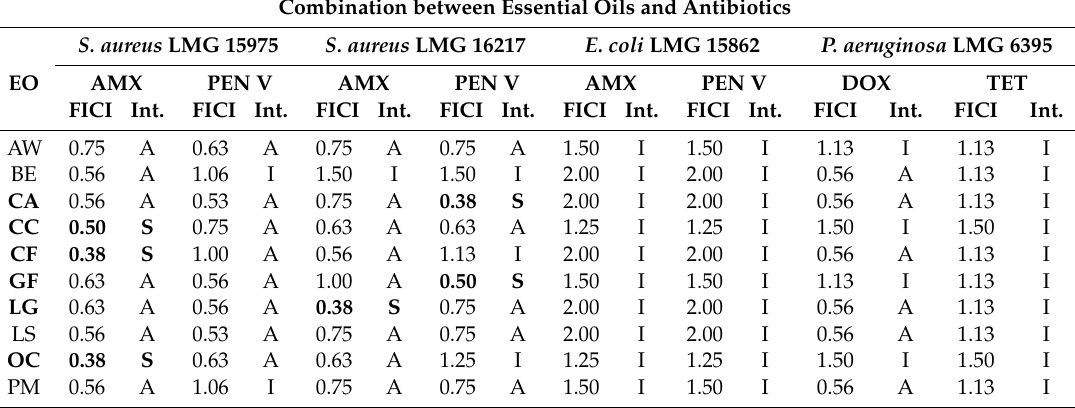
Table 4. Synergistic activity of the essential oils combined with antibiotics, both at active concentrations in a 1:1 ratio against two MRSA, E. coli and P. aeruginosa ( n = 3). In bold, the most promising results. Combination between Essential Oils and Antibiotics